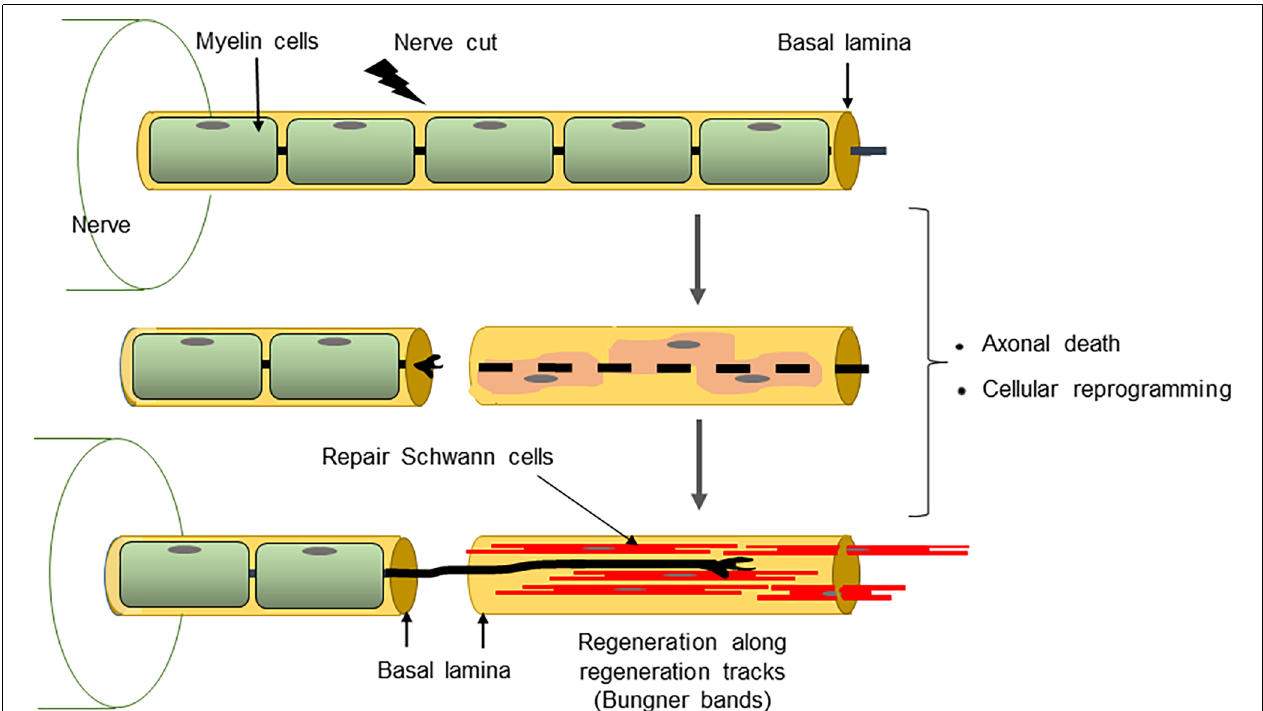
FIGURE 4 | The conversion of myelin cells to repair cells and the formation of Bungner bands.